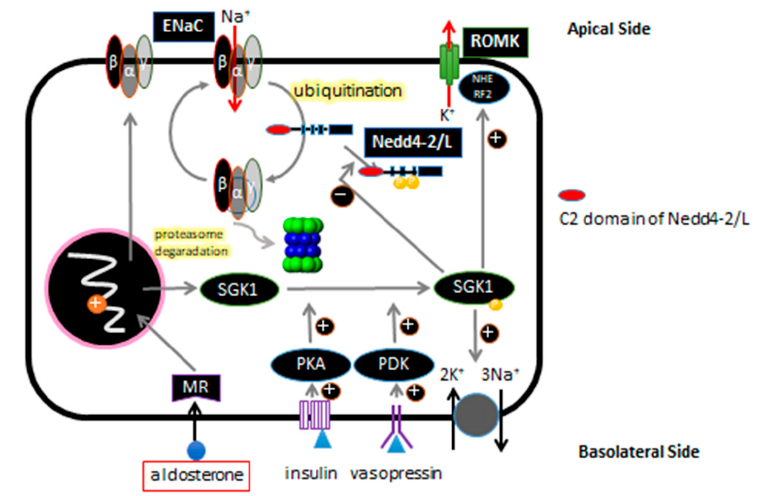
Figure 1. Schematic presentation of the ASDN epithelial cell is shown. ENaC is ubiquitinated by Nedd4-2/Nedd4L, and subsequently degraded by proteasome. Aldosterone, insulin, and vasopressin regulate ENaC gene expression via the basolateral side.